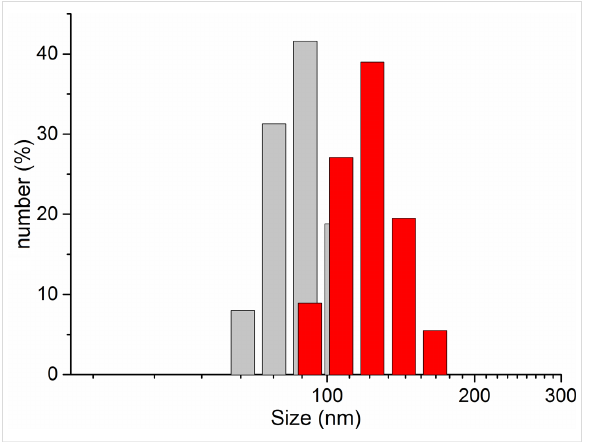
Figure 1: DLS (hydrodynamic size) results of C 60 FAS (grey; concen- tration 0.15 mg/mL) and C 60 +Cis mixture (red; molar ratio of 1:2.4).